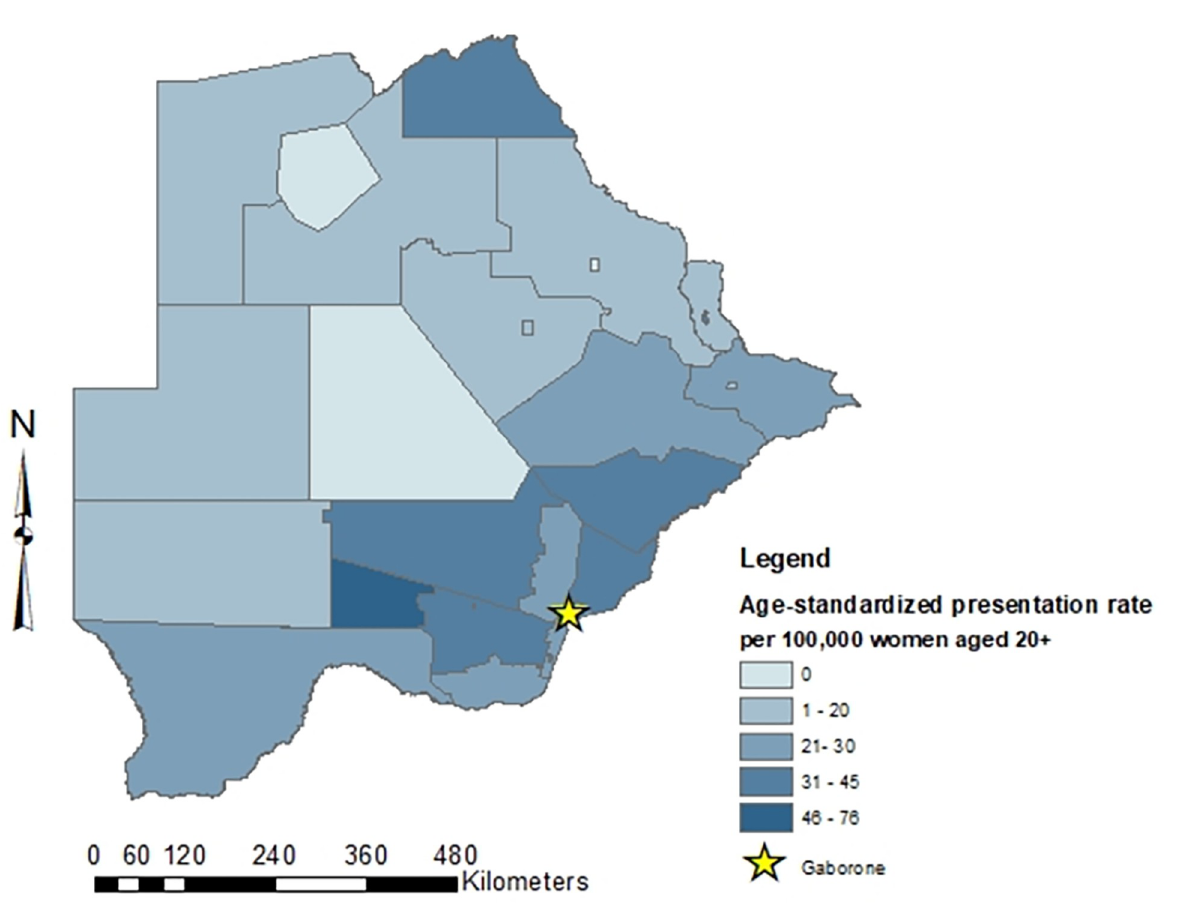
Fig 1. Age- standardized presentation rates to the MDT clinic in Gaborone, Botswana per sub-district � . � created in ArcGIS version 10.6.1 (Esri, Redlands, CA).